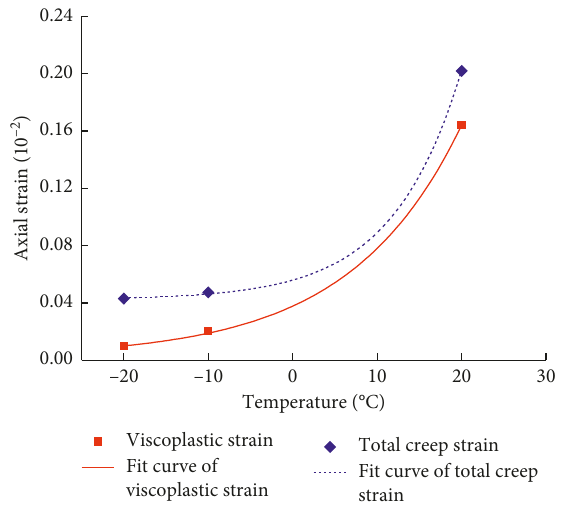
Figure 9: Total creep and viscoplastic strains versus